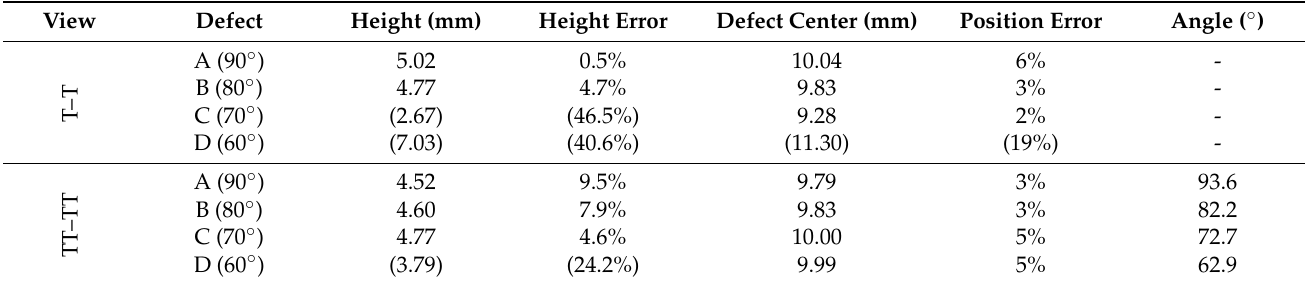
Figure 14. TT–TT views of notch C for ( a ) TFM and ( b ) IPCI. Table 4. Defects height, center position, and related errors for both T–T and TT–TT views using the IPCI algorithm. Angle of the defect determined using the principal axis of the TT–TT view.